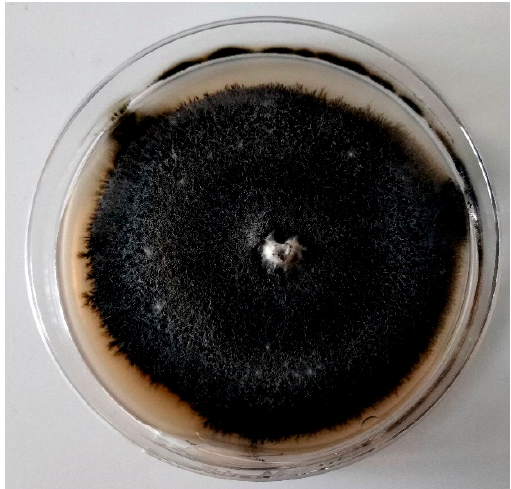
Figure 1. Verticillium sp. isolated on PDA medium from ecological strawberry plantation after 10 days of incubation in 22 °C.